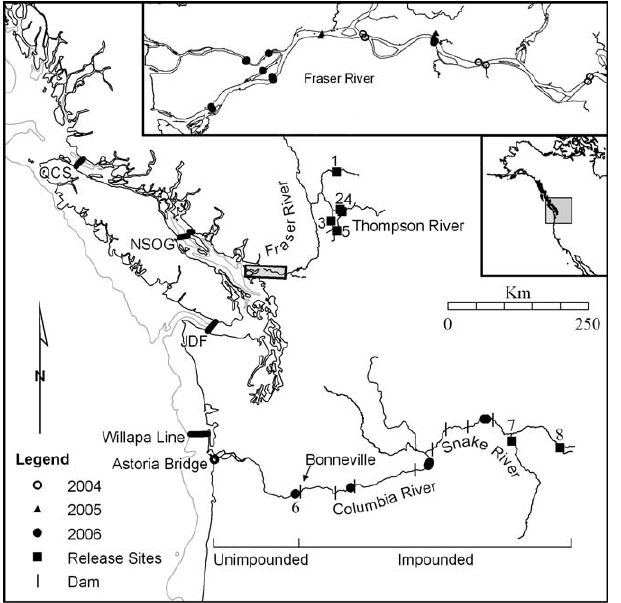
Figure 1. Geographic Location of Part of the POST Acoustic Array and Smolt Release Sites The edge of the continental shelf (200-m depth contour) is shown, as well as acoustic listening lines located in the two rivers and in the Strait of Juan de Fuca (JdF) and northern Strait of Georgia (NSOG). Position of the 2002–2004 lower Columbia River array at Astoria is described in [30]. Release sites, marked with a filled square are as follows: 1: Deadman River; 2: Nicola River; 3: Spius Creek; 4: Coldwater River; 5: Coldwater River; 6: Bonneville Dam; 7: Snake River trap; and 8: Kooskia National Fish Hatchery. Receiver locations marked with open circles indicate 2004; filled triangles 2005; and filled circles 2006.